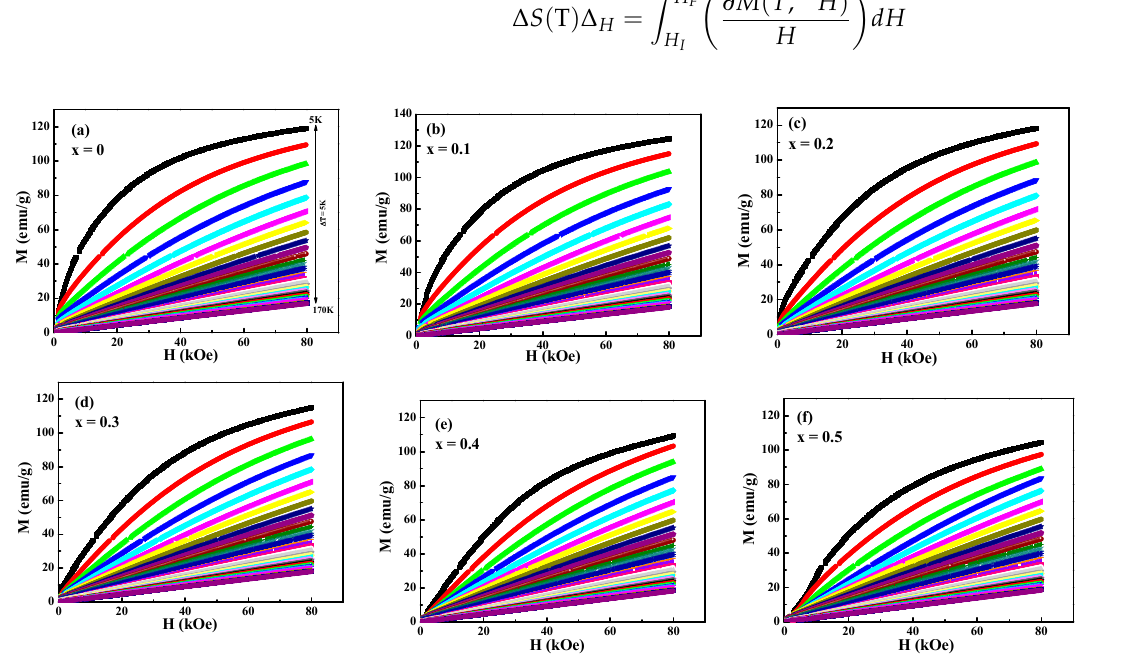
Figure 8. ( a – f ): Isothermal magnetization M–H curves of the GECMO series.